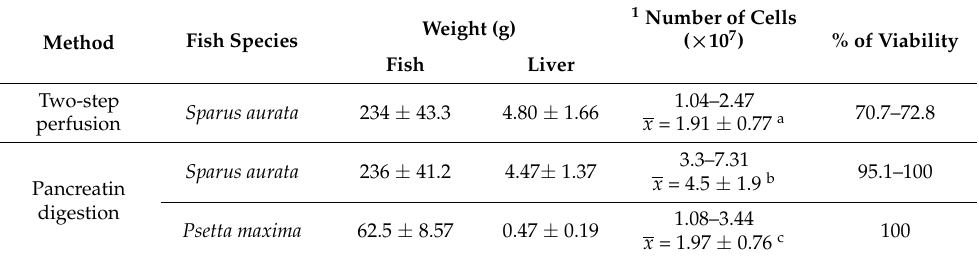
Table 1. Total number of primary hepatocyte cells (range and average) isolated from the liver of S. aurata and P. maxima fish obtained by different cell isolation methods, two-step collagenase perfusion and pancreatin digestion, and their respective cell viability